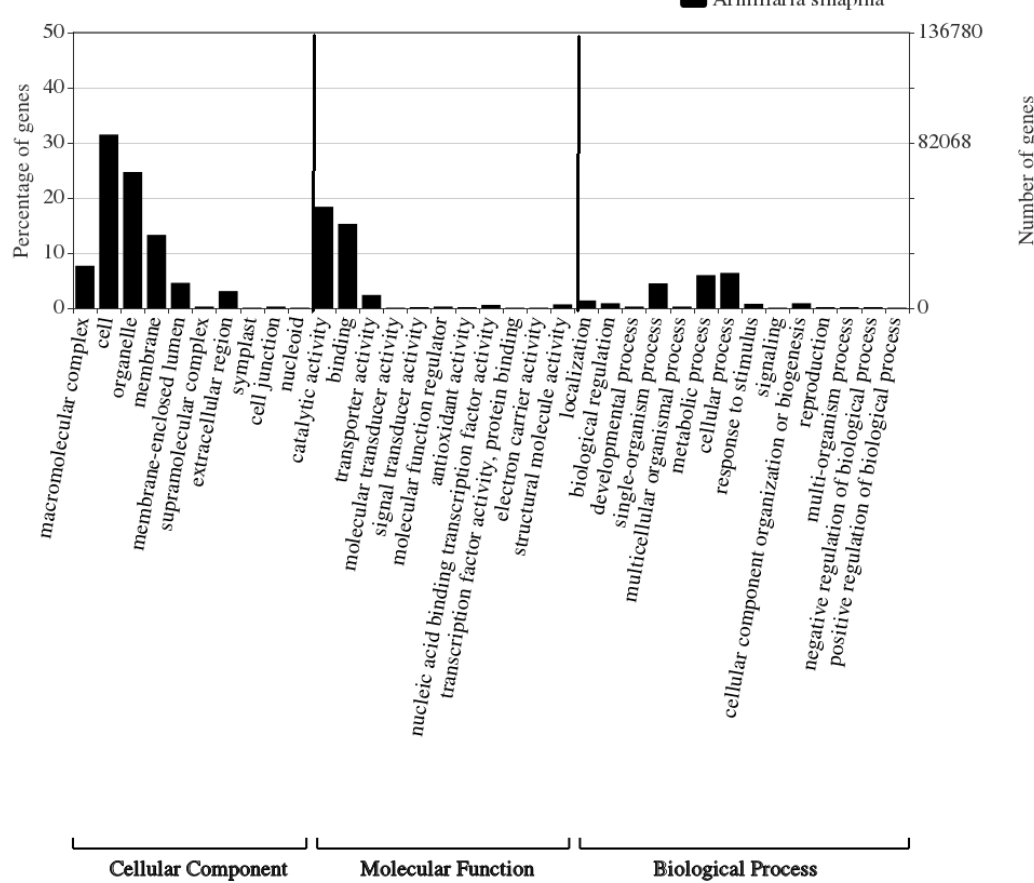
Figure 2. Gene Ontology (GO) terms of 35 functional groups of expressed transcripts from Armillaria sinapina.